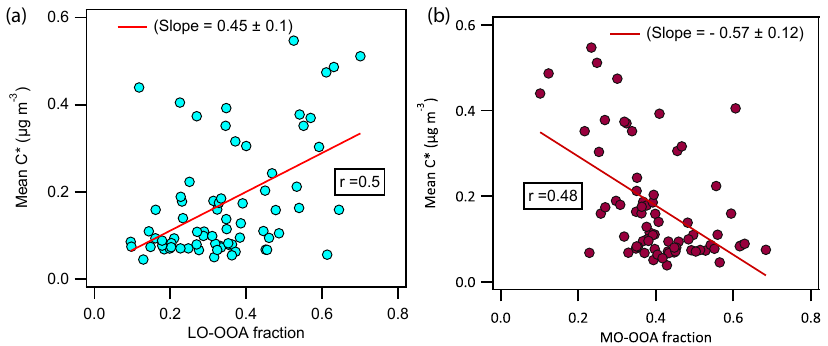
Figure 8. Scatter plot of mean C ∗ versus (a) LO-OOA fraction, and (b) MO-OOA fraction in total OA concentration during the Centreville campaign.